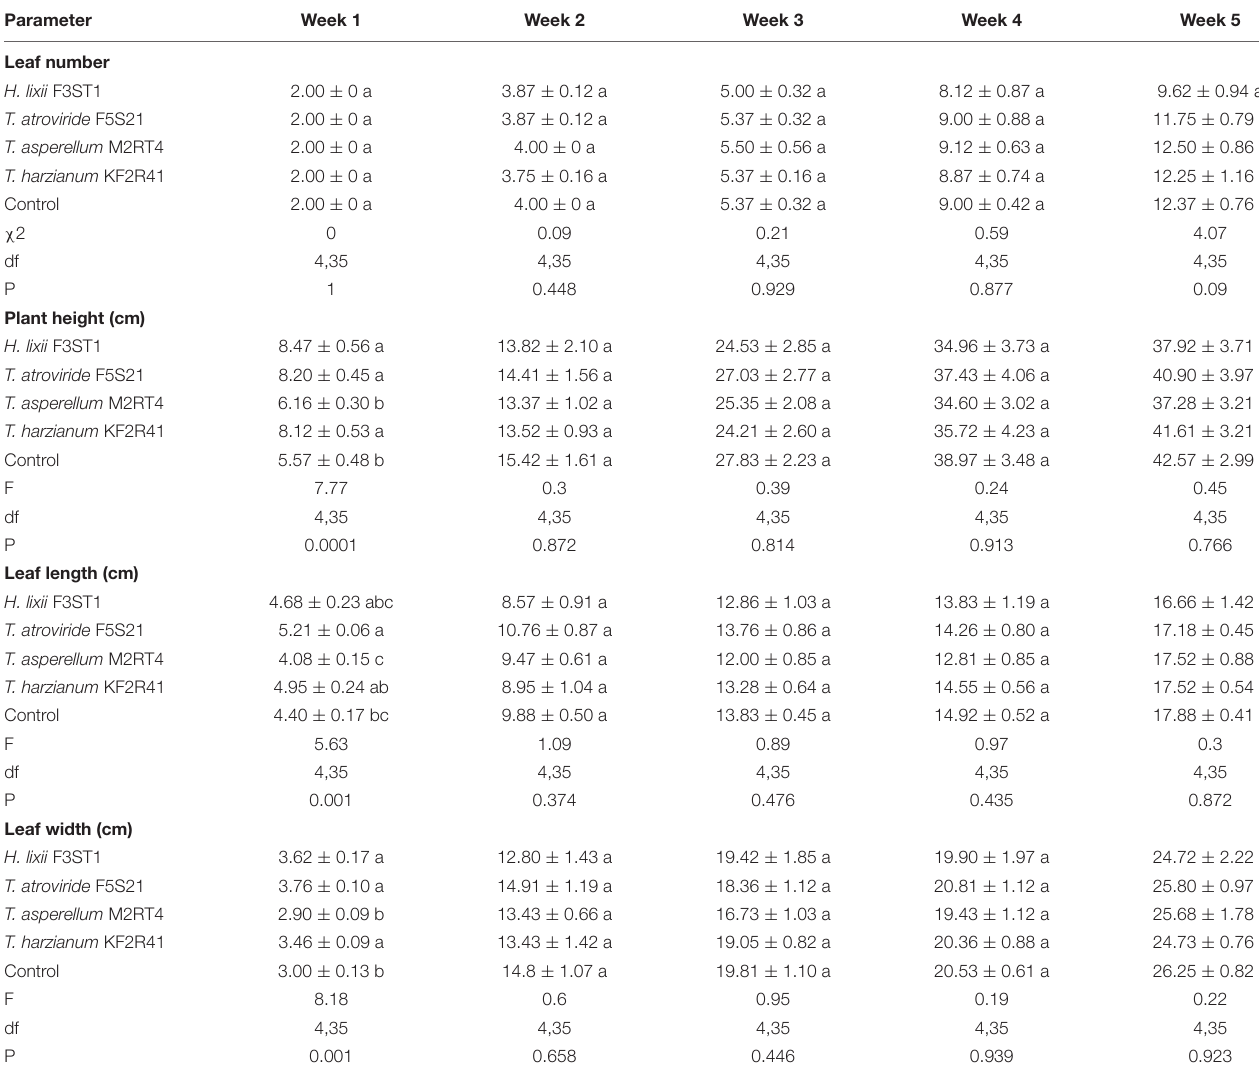
TABLE 2 | The effect of the seed inoculation of H. lixii F3ST1, T. asperellum M2RT4, T. atroviride F5S21, and T. harzianum KF2R41 on the growth parameters of Phaseolus vulgaris.